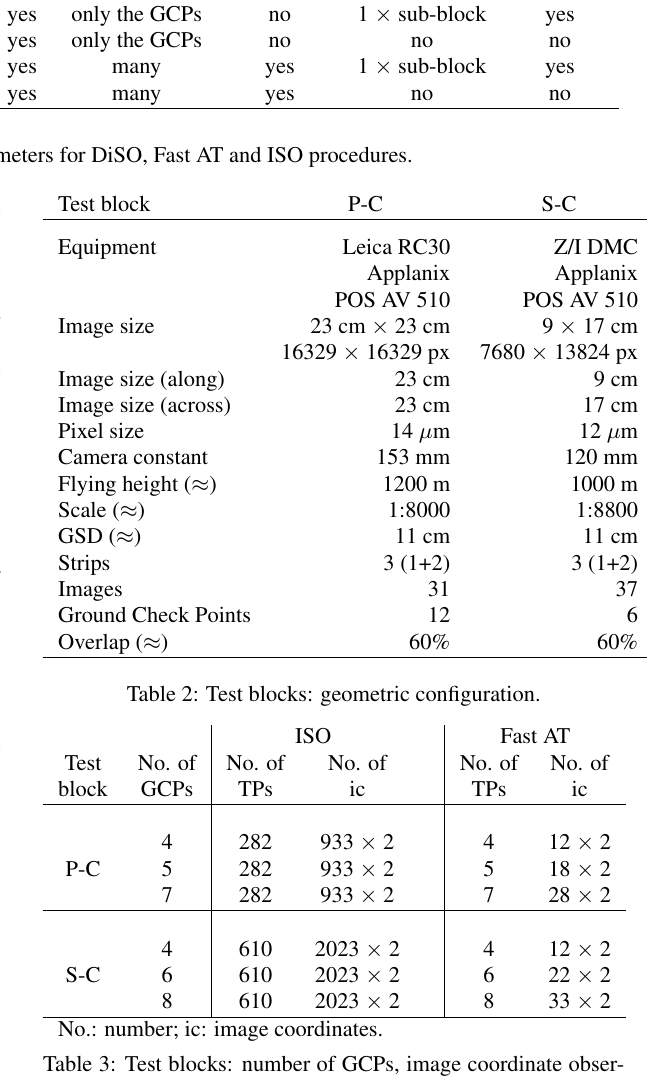
Table 3: Test blocks: number of GCPs, image coordinate obser- vations and